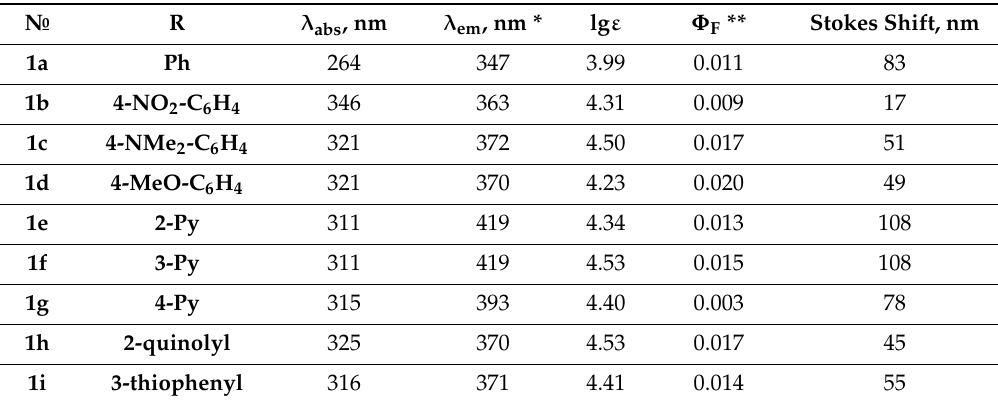
Table 1. Photophysical data of compounds 1a–1i